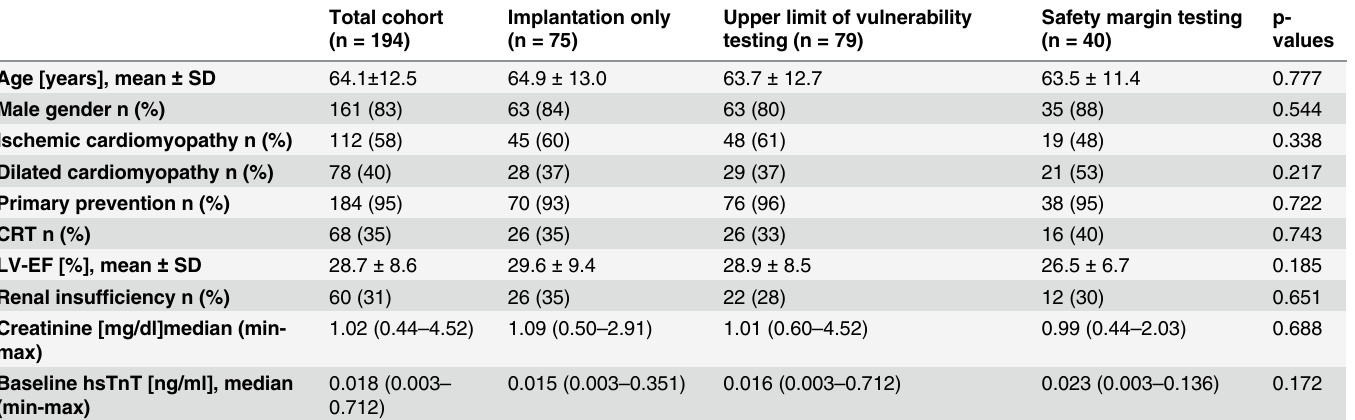
Table 2. Patient characteristics.